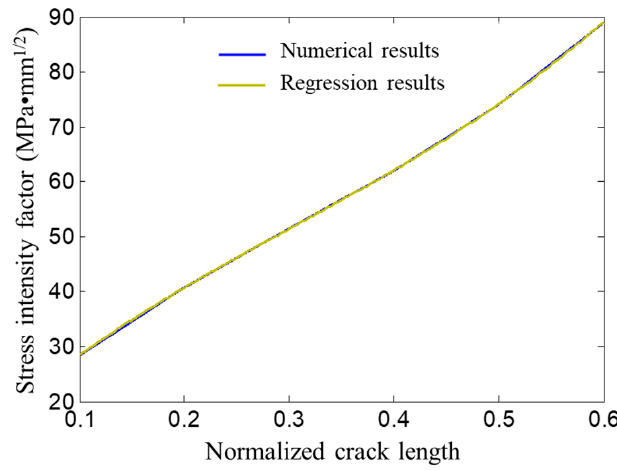
Figure 12. Comparison between numerical and regression results.